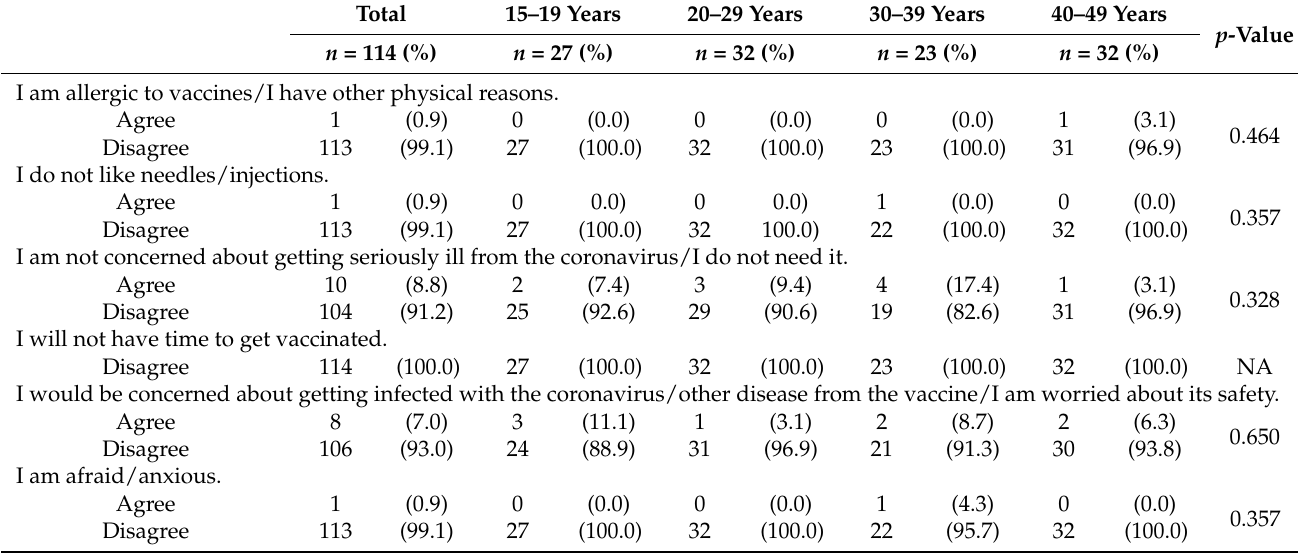
Table 4. Reasons for the response, “I will not get vaccinated” or, “I am not sure”, regarding the third